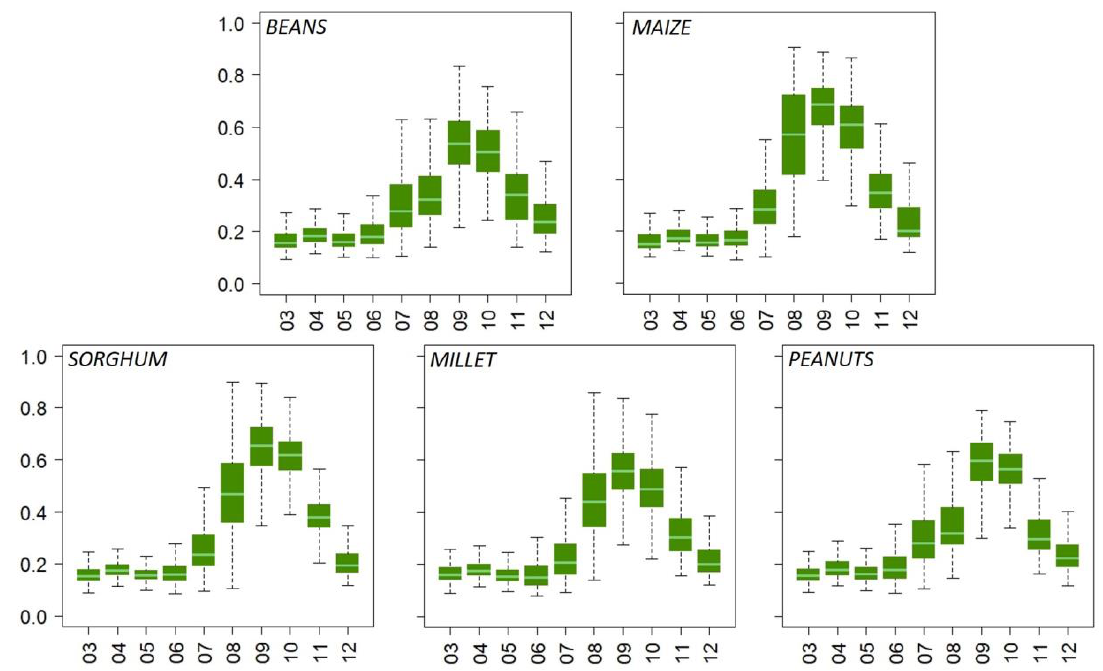
Figure 2. Exemplary annual normalized difference vegetation index (NDVI) development for all surveyed fields per crop type. NDVI values on the y-axis and respective months (starting with March) on the x-axis.